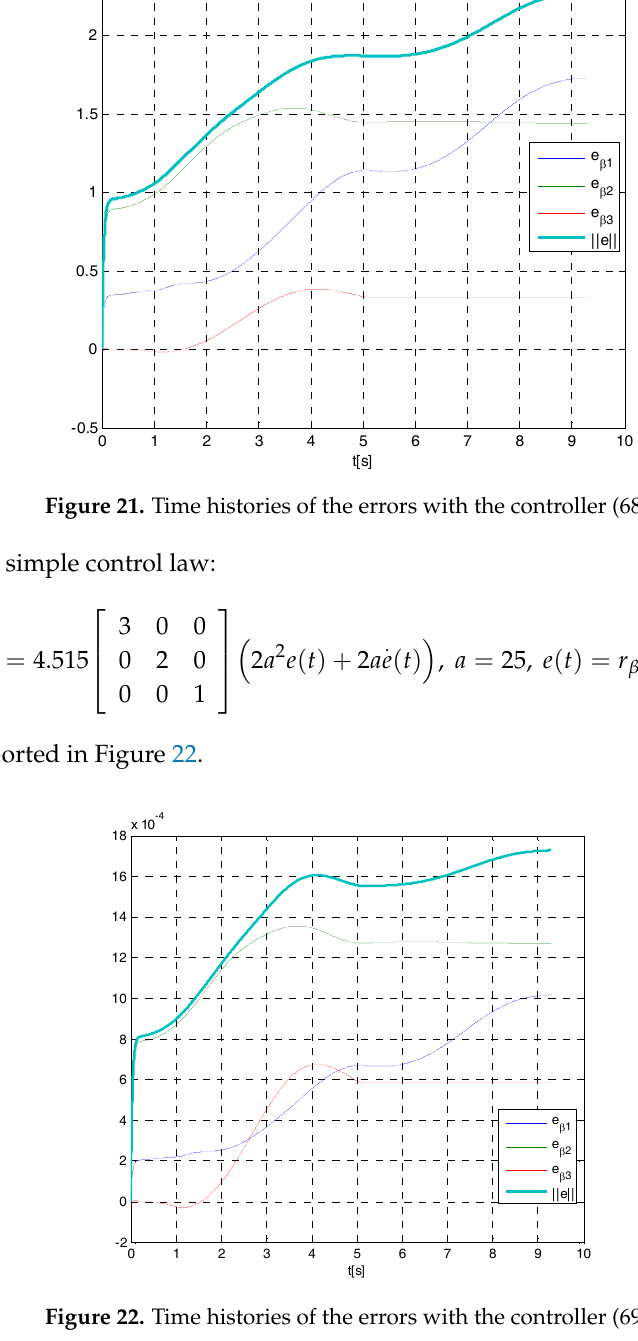
Figure 22. Time histories of the errors with the controller (69).